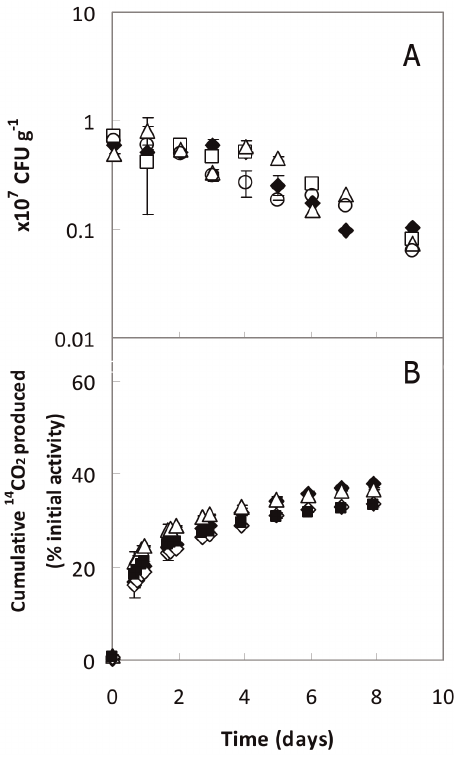
Figure 2. Effects of S -MET in Pseudomonas sp. ADP Rif R (A) survival and (B) ATZ- mineralization in soil. In ( A ), soil previously contaminated with 24 m g ATZ g 2 1 of soil was supplemented with increasing concentrations of S -MET, namely 0 ( X ), 15 ( % ), 30 ( D ) or 60 ( # ) m g g 2 1 of soil, prior to inoculation. In ( B ), soil was spiked with a total of 24 m g ATZ g 2 1 of soil (including [ 14 C]ATZ) plus 30 m g S -MET g 2 1 ( D ) or no S -MET ( X ), or with a total of 40 m g ATZ g 2 1 plus 50 m g S - MET g 2 1 ( & ) or no S -MET ( e ), prior to inoculation. Data are means 6 SD of measurements from at least duplicate determinations from two or three independent experiments under identical